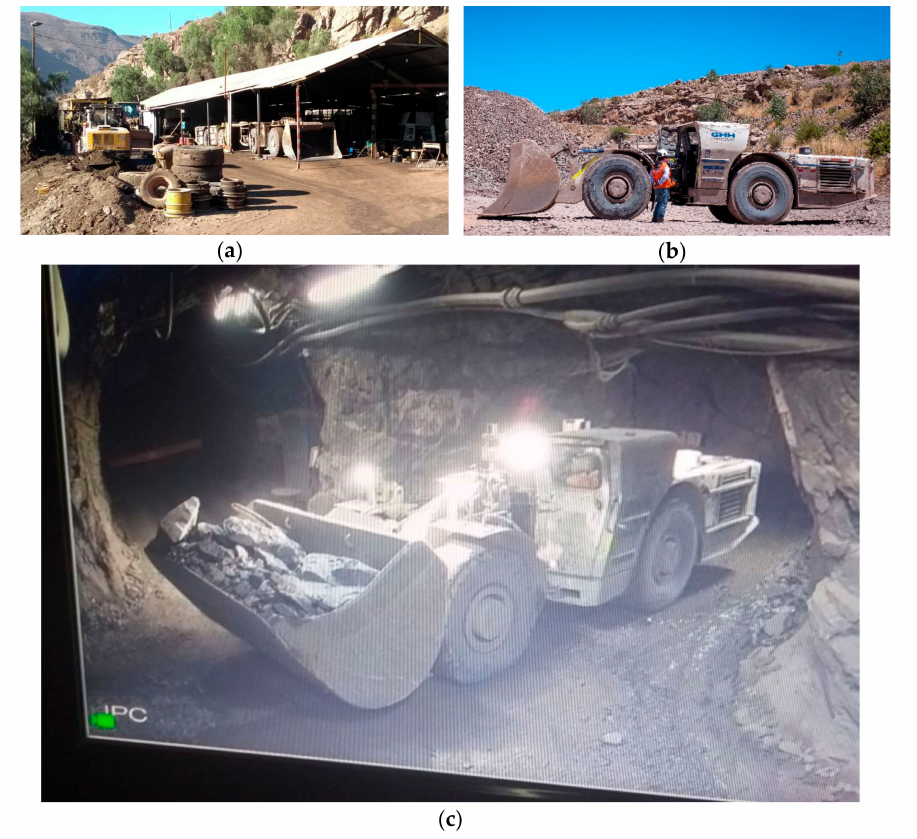
Figure 20. LHD machine and mining facility. ( a ) Mechanical workshop just outside the mine’s main entrance; ( b ) LHD during surface tests; ( c ) LHD outside the test tunnel with an almost fully loaded